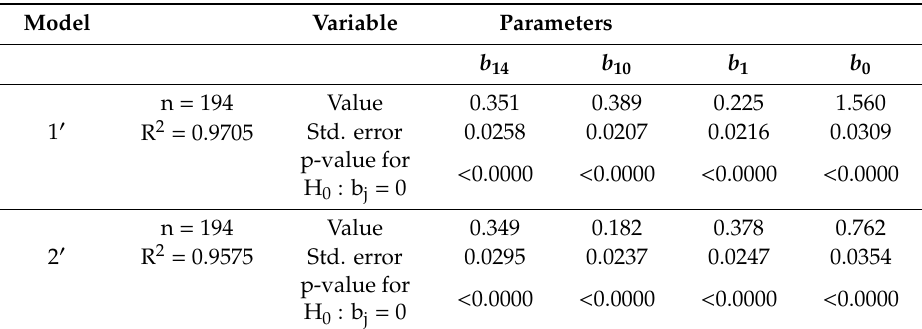
Table 2. Parameters and statistic data for the readjusted models: model 1 (cid:48) for predicting PCDD / F amounts (pg) and model 2 (cid:48) for TEQ values (pg